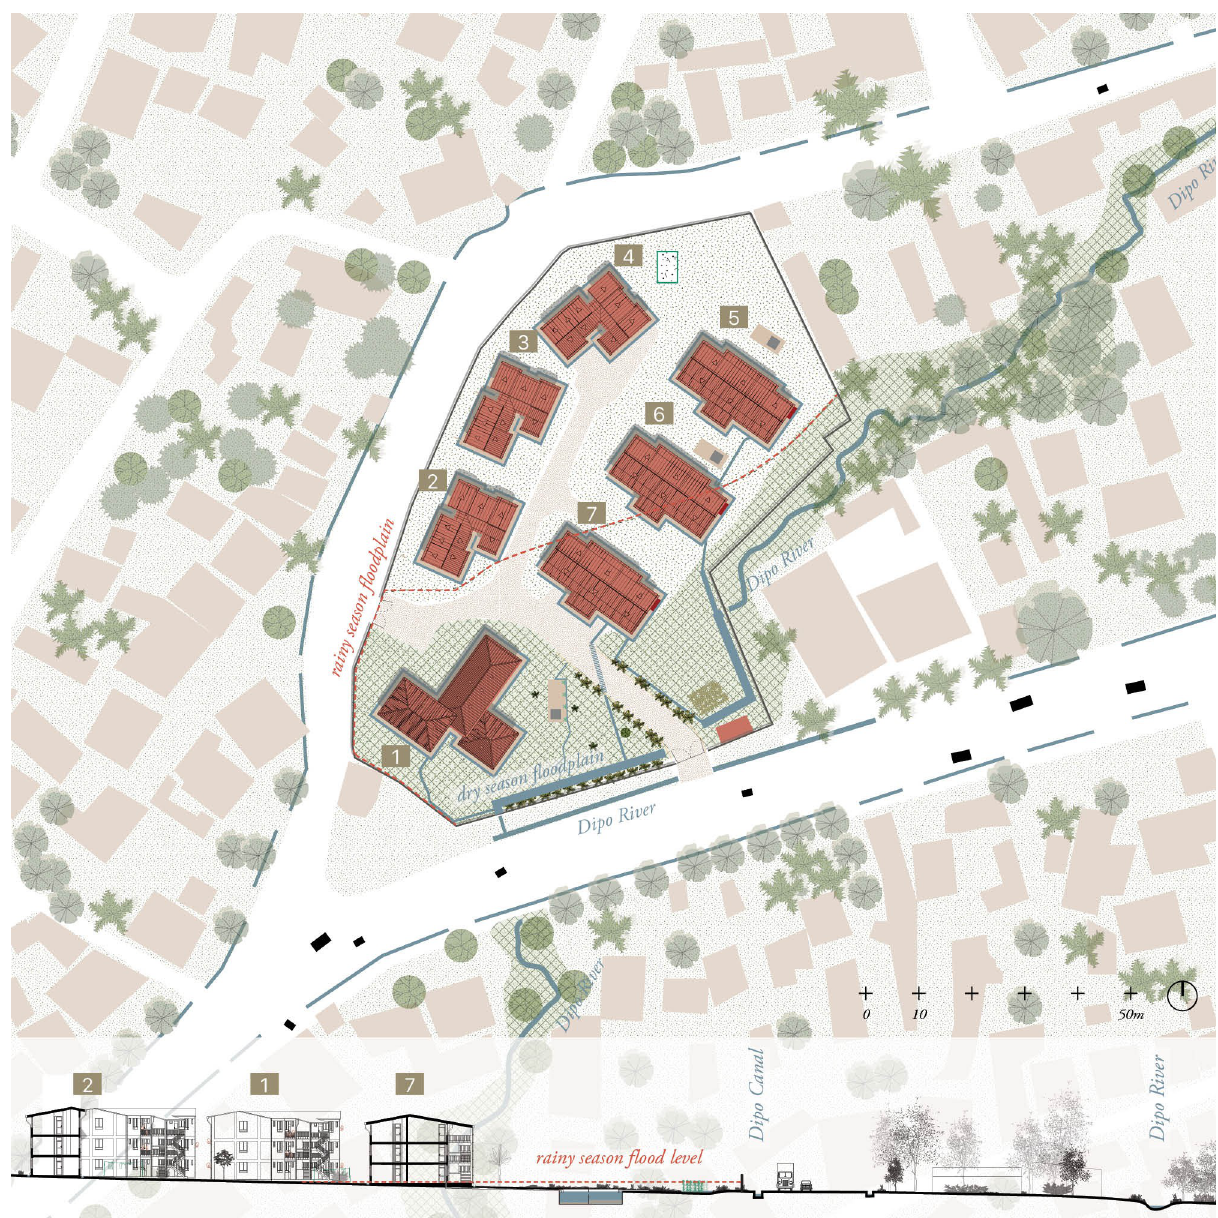
Fig 6. Disruptive water networks in Condominium D. Condominium D is located in the Dipo River floodplain, flooding the site moderately in dry season and extensively in rainy season (red dotted line). Within the walls of the condominium, the river is canalised and used as outlet for both the rain gutter network coming from the housing blocks and the septic tanks. The site suffers from permanently stagnating water. Map drawn by the authors , based on https://www.usgs.gov/ and openstreetmap.org